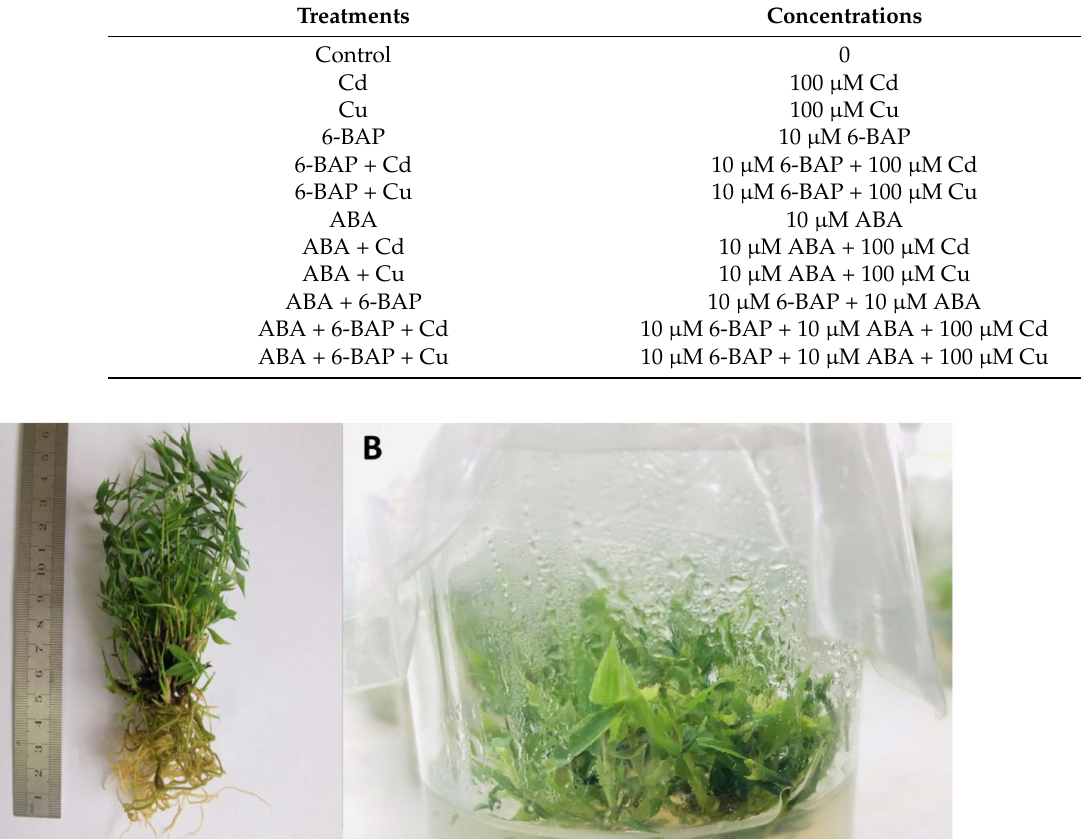
Table 1. The experimental design.